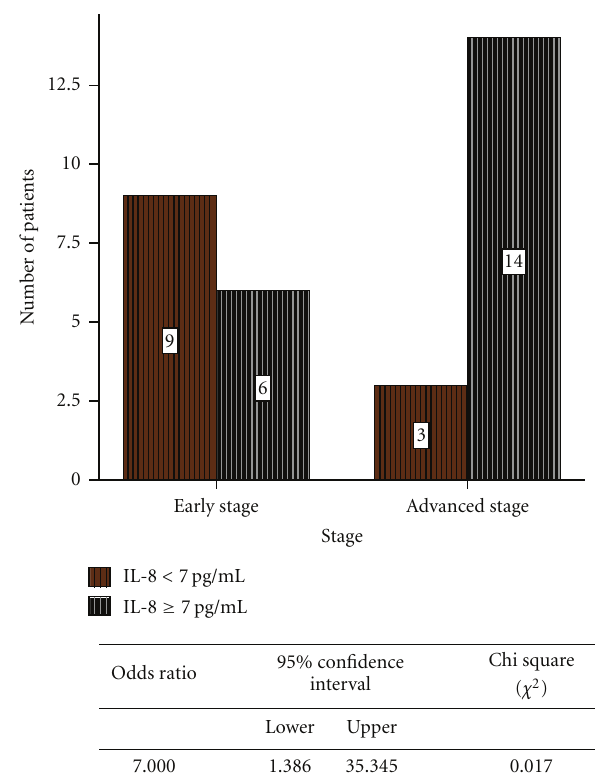
Figure 4: Relative risk of IL-8 in early- and advanced-stage thyroid carcinoma